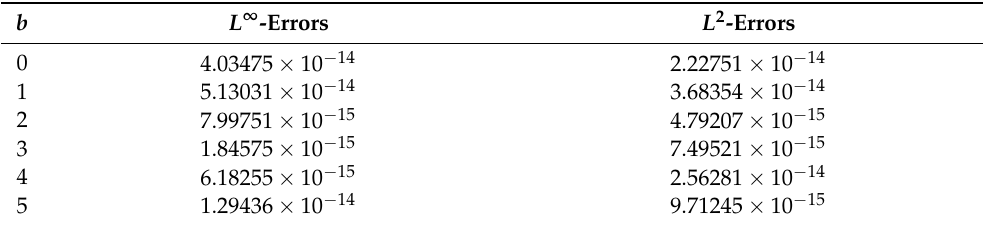
Table 1. Comparison of L ∞ - and L 2 -errors of our algorithm at υ 1 = 0.25 and N = 4 with distinct b for Example 1.